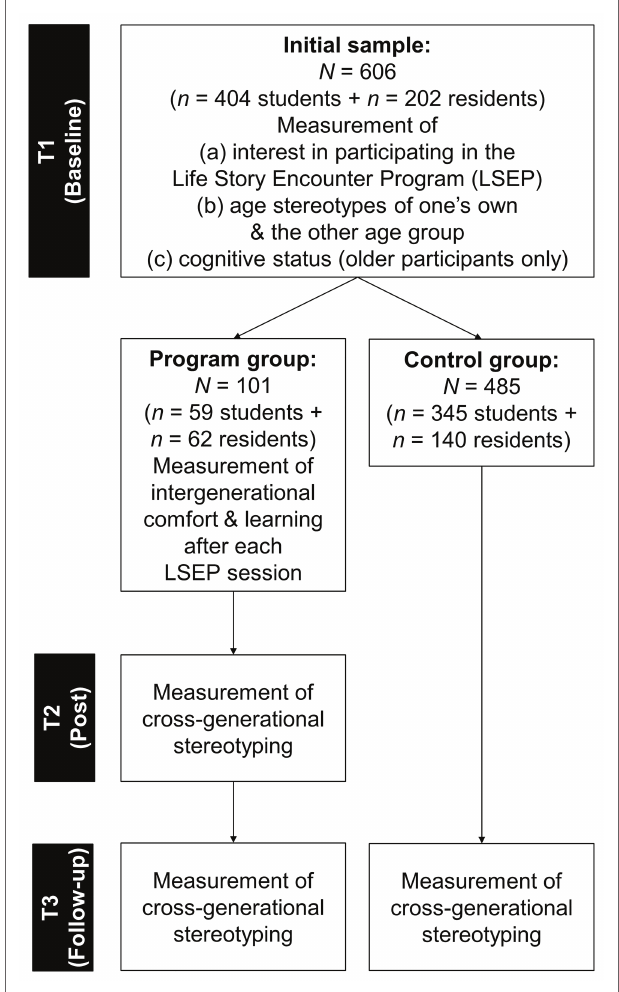
FIGURE 1 | Schematic overview of the study